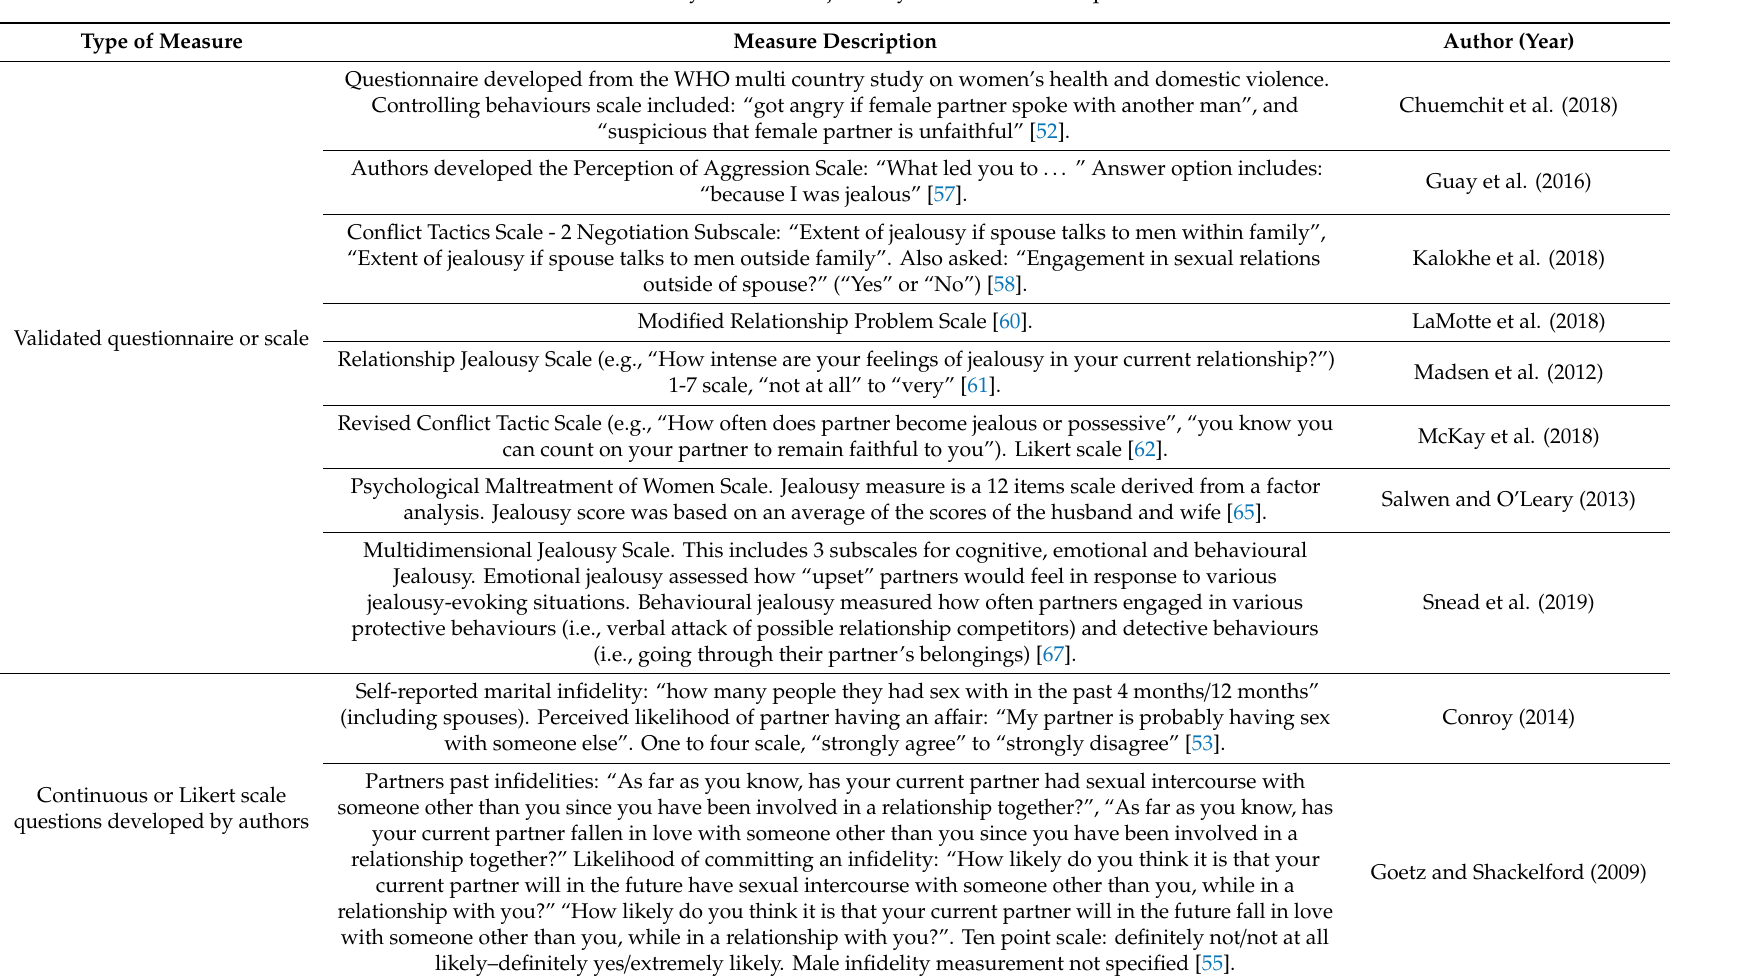
Table A3. Measures of infidelity or romantic jealousy used in included quantitative